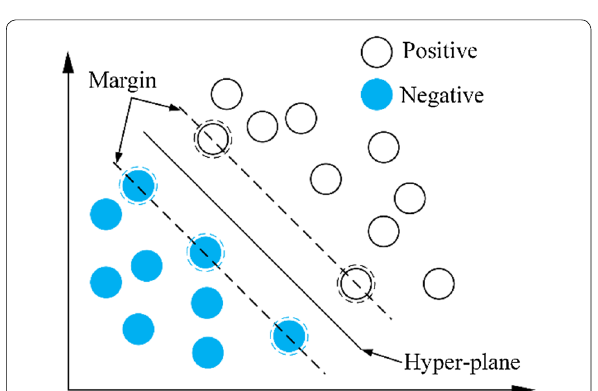
Figure 5 Classification of two tapes using